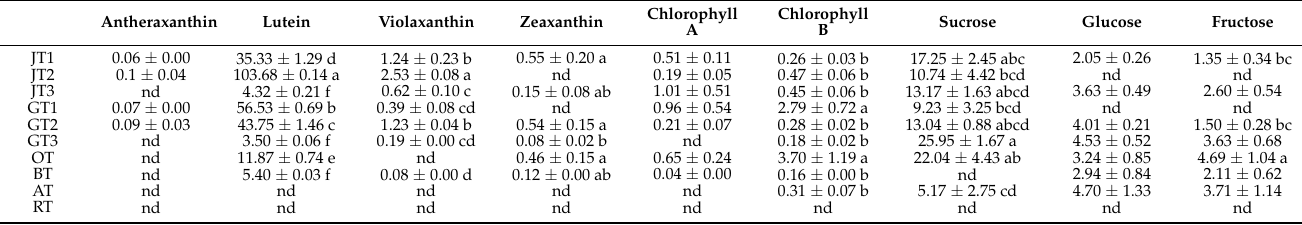
Table 4. Carotenoid ( µ g/g) and saccharide contents (mg/g) in the teas and herbal teas. Antheraxanthin Lutein Violaxanthin Zeaxanthin Chlorophyll A Chlorophyll